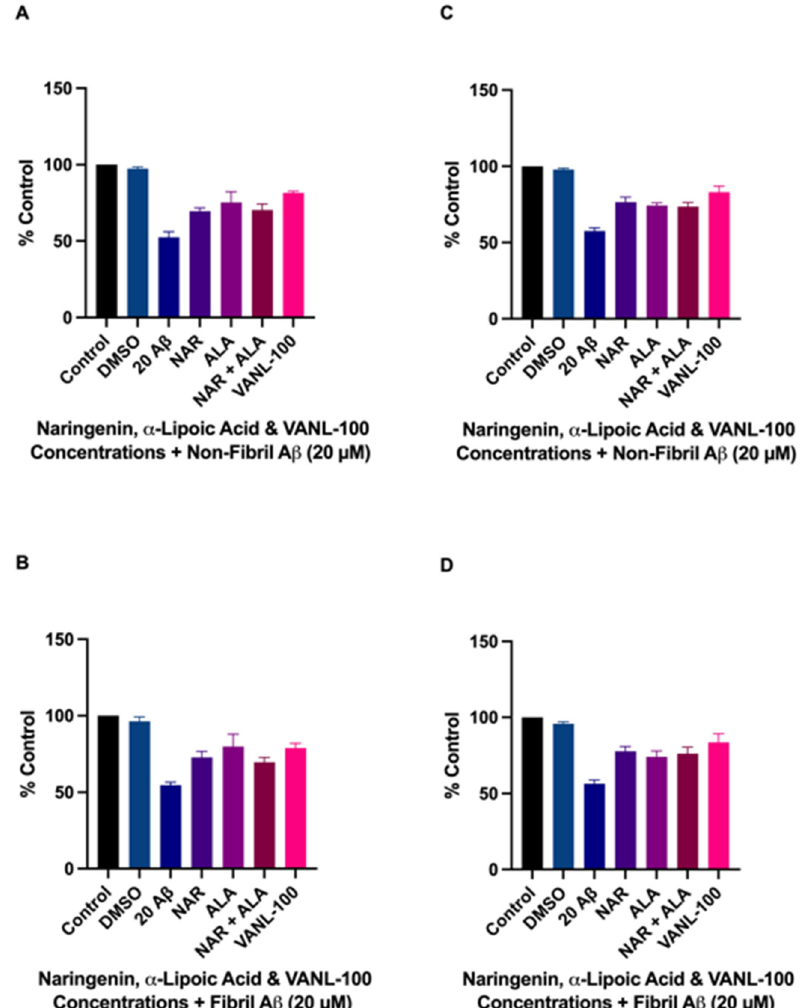
Figure 6. Effects of pre-treatment and co-treatment with VANL-100 compared to parent com- pounds. Cell viability, represented as % control, is shown on the y-axis, and antioxidant concentra- tions are displayed on the x-axis. The bars represent the mean ± SEM of six independent experi- ments. ( A , B ) Pre-treatment with VANL-100 compared to parent compounds against non-fibril and fibril A β 25–35 , respectively. ( C , D ) Co-treatment with VANL-100 compared to parent compounds against non-fibril and fibril A β 25–35 , respectively. Statistical significance vs. VANL-100 was assessed using one-way ANOVA. p < 0.05.